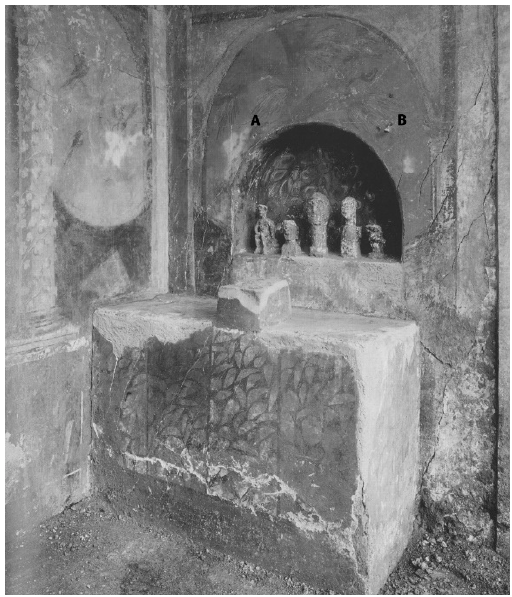
Figure 13. Casa del Menandro (1.10.4), Pompeii. Room 25, with niche containing busts of ancestors. Indications for garlands shown by letters ( A , B ). (Modified by author, after PPM 2.373).